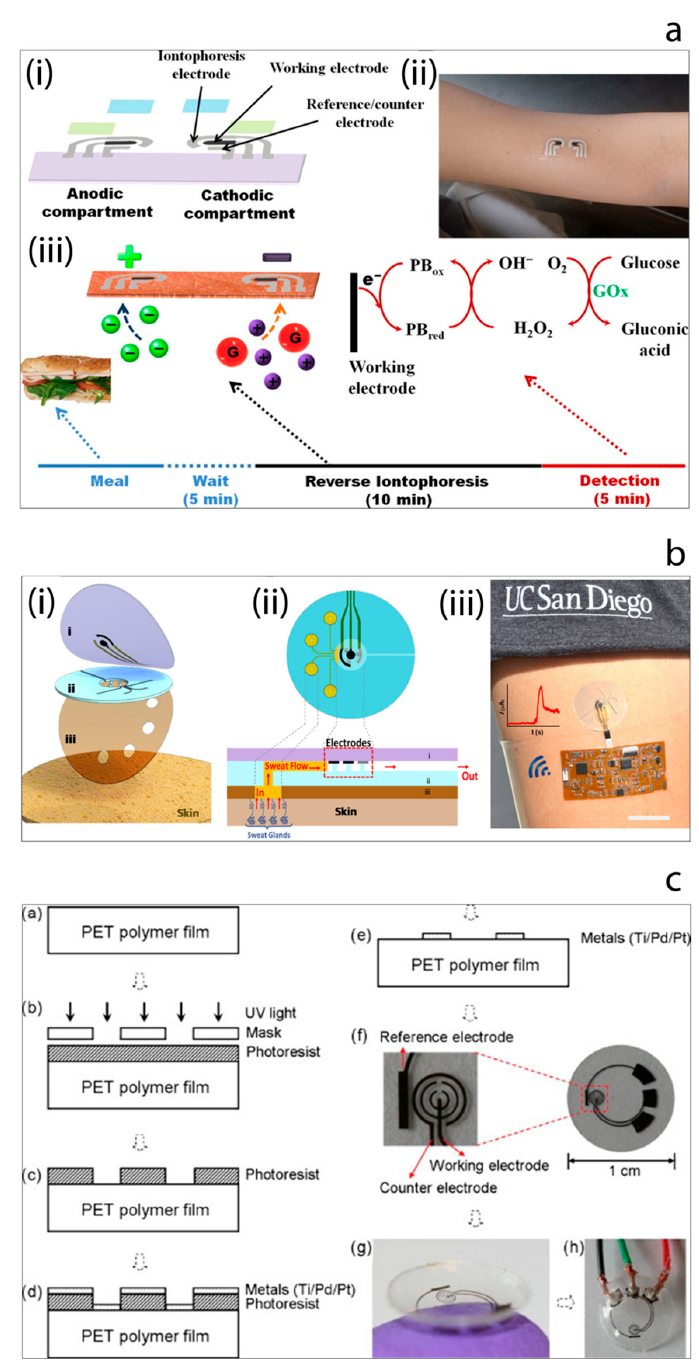
Figure 8. ( a ) Tattoo-based noninvasive glucose sensing platform: (i) schematic image of the printable iontophoretic-sensing system, (ii) photograph of the tattoo-based glucose sensor device applied to a human object, (iii) schematic image of the time frame of a typical on-body study [115]. ( b ) Microfluidic device design and operation: (i) schematic image of the layered microfluidic device configuration, (ii) schematic representation of microfluidic device sweat collection and operation on skin, (iii) photograph of the device integrated with wireless conformal electronics on skin [117]. ( c ) The contact lens sensor fabrication process and resulting contact lens with embedded sensor